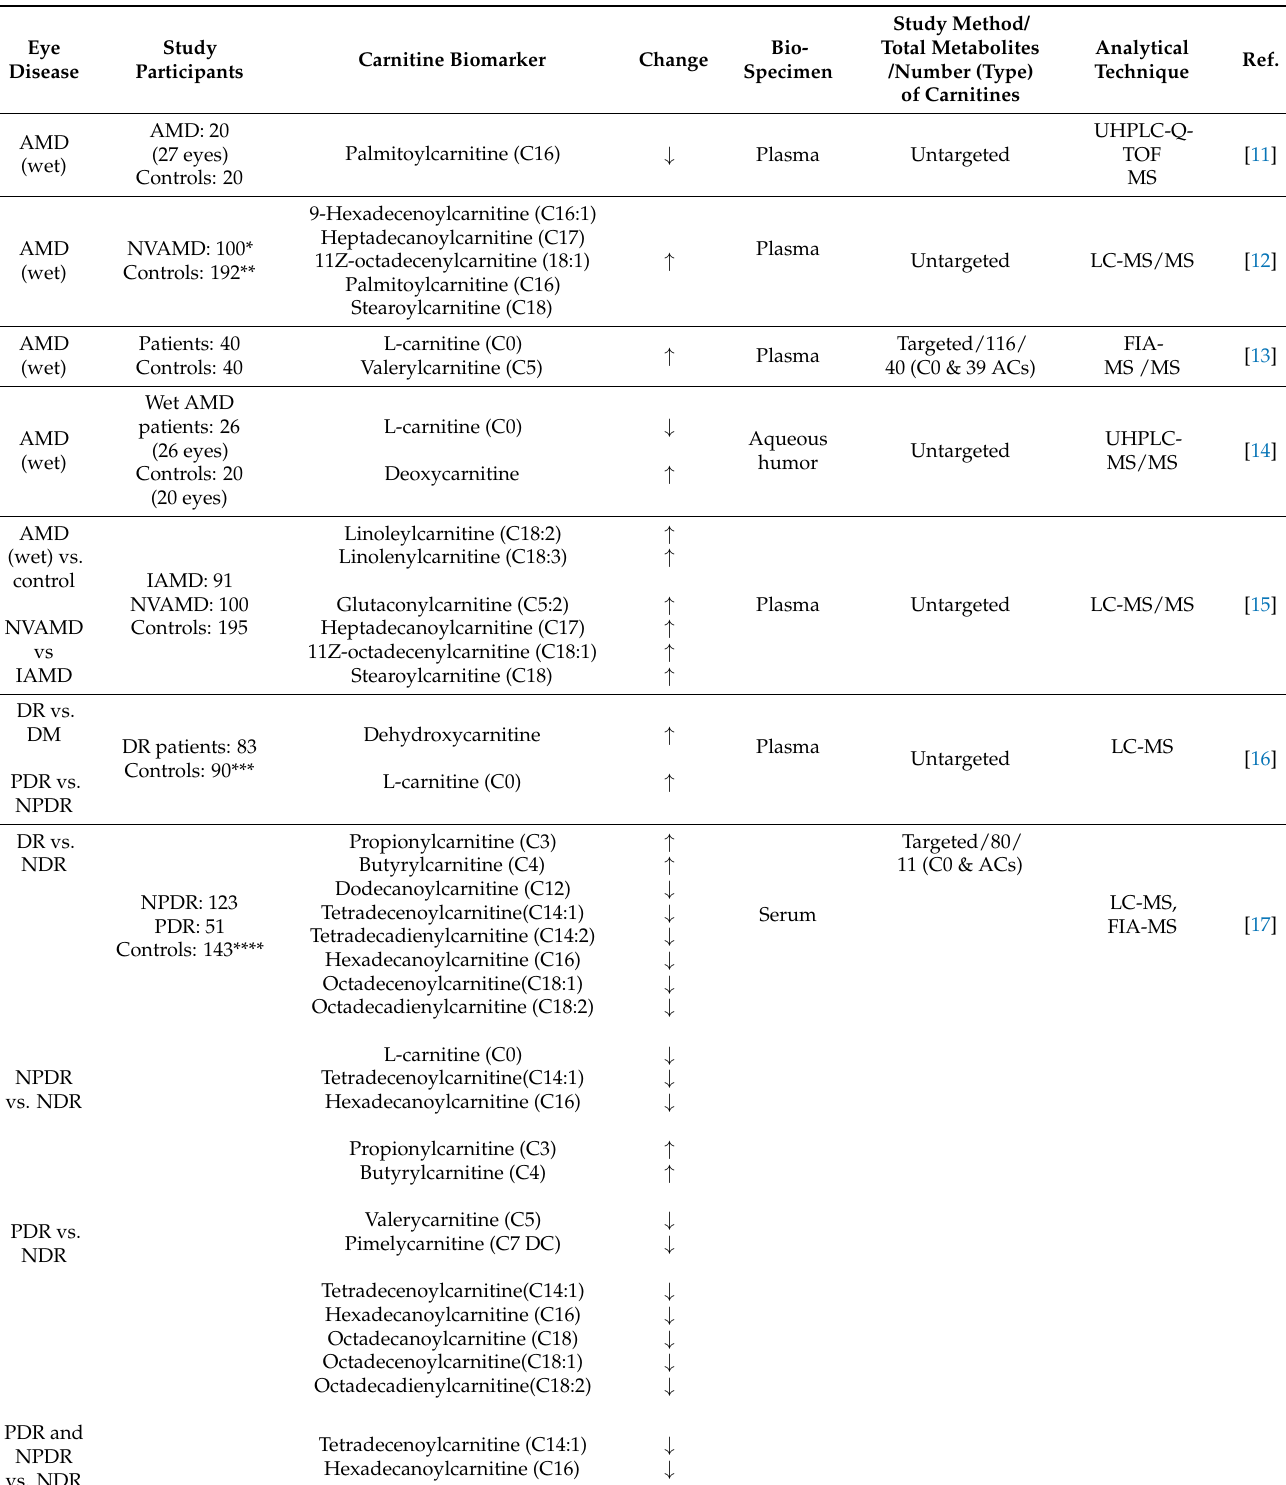
Table 1. General information about metabolic profiling studies performed for eye diseases focusing on